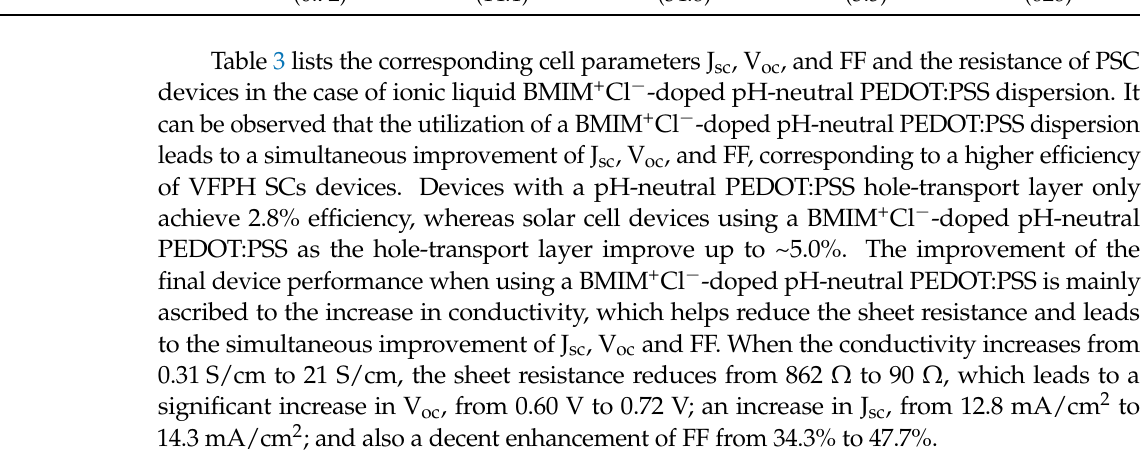
Table 3. Photovoltaic parameters of PTB7:PCBM solar cells with BMIM + Cl − -doped neutral PE- DOT:PSS as hole-transport layers used with liquid EGaIn